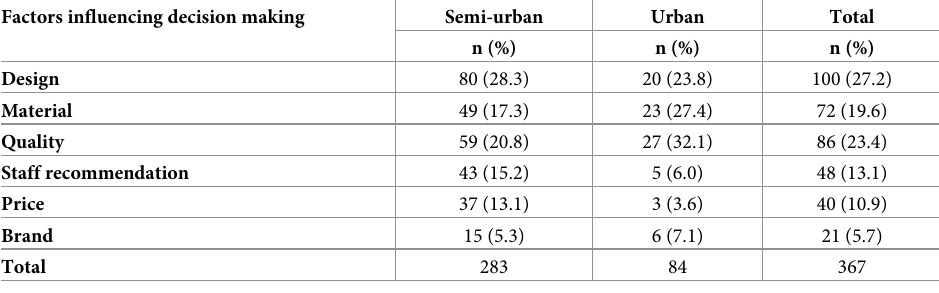
Table 3. Factors influencing decision making in the sample (total responses = 367).